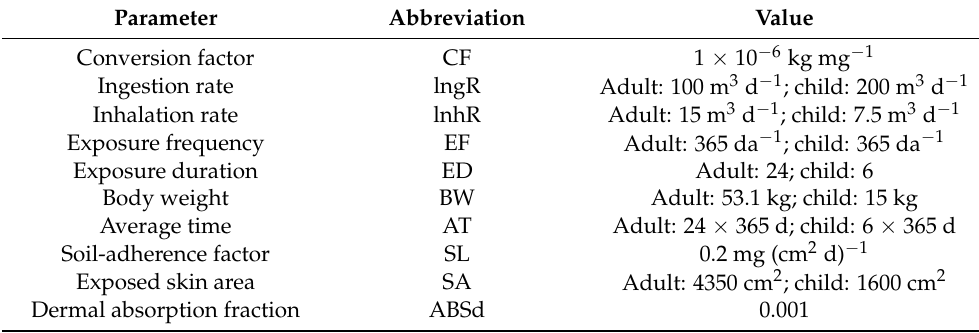
Table 1. The exposure parameters for the ADI estimation.